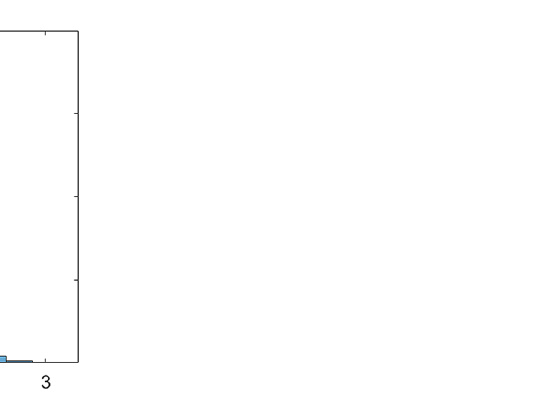
Figure 4. Intra-subject correlation of the J 0 ( A ) and J 45 ( B ) components of the power vector measured at 6 mm and the other concentric areas (from 2 to 5 mm). The black line refers to x = y; the dashed line is the linear regression model; R 2 is the correlation coefficient.